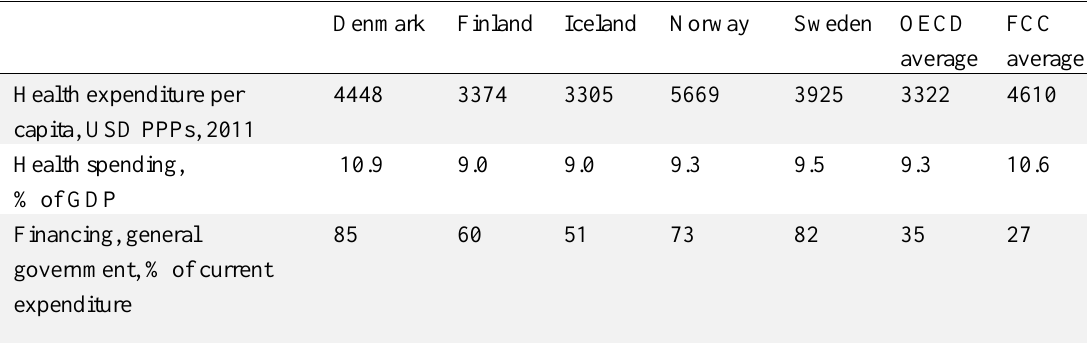
FCC average average